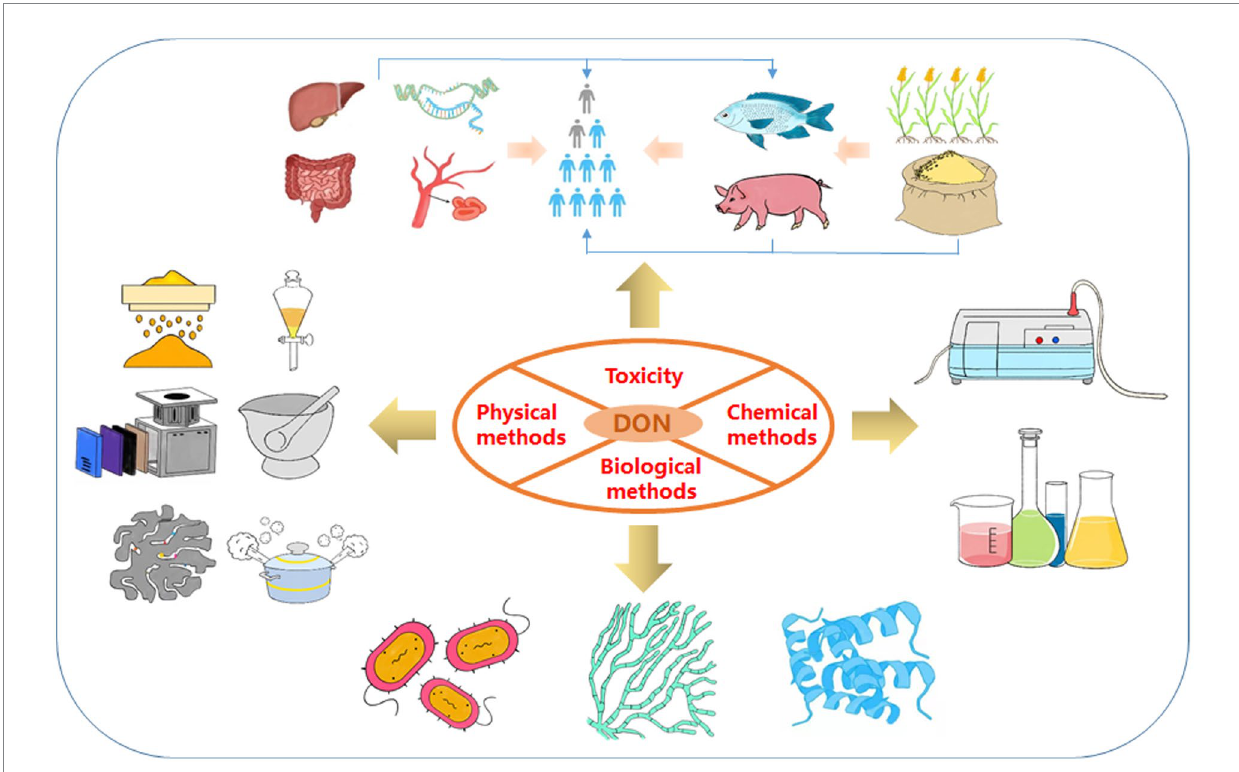
FIGURE 1 Framework of the review. These include the toxicity of DON and three detoxification methods (physical methods, chemical methods and biological